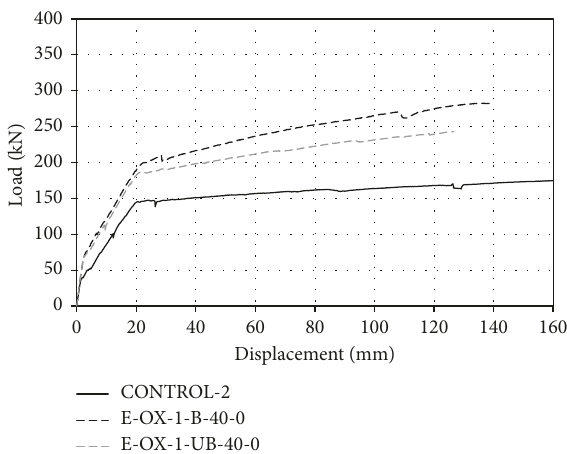
Figure 23: Strengthening effect w.r.t. eventual bonding of tendon.